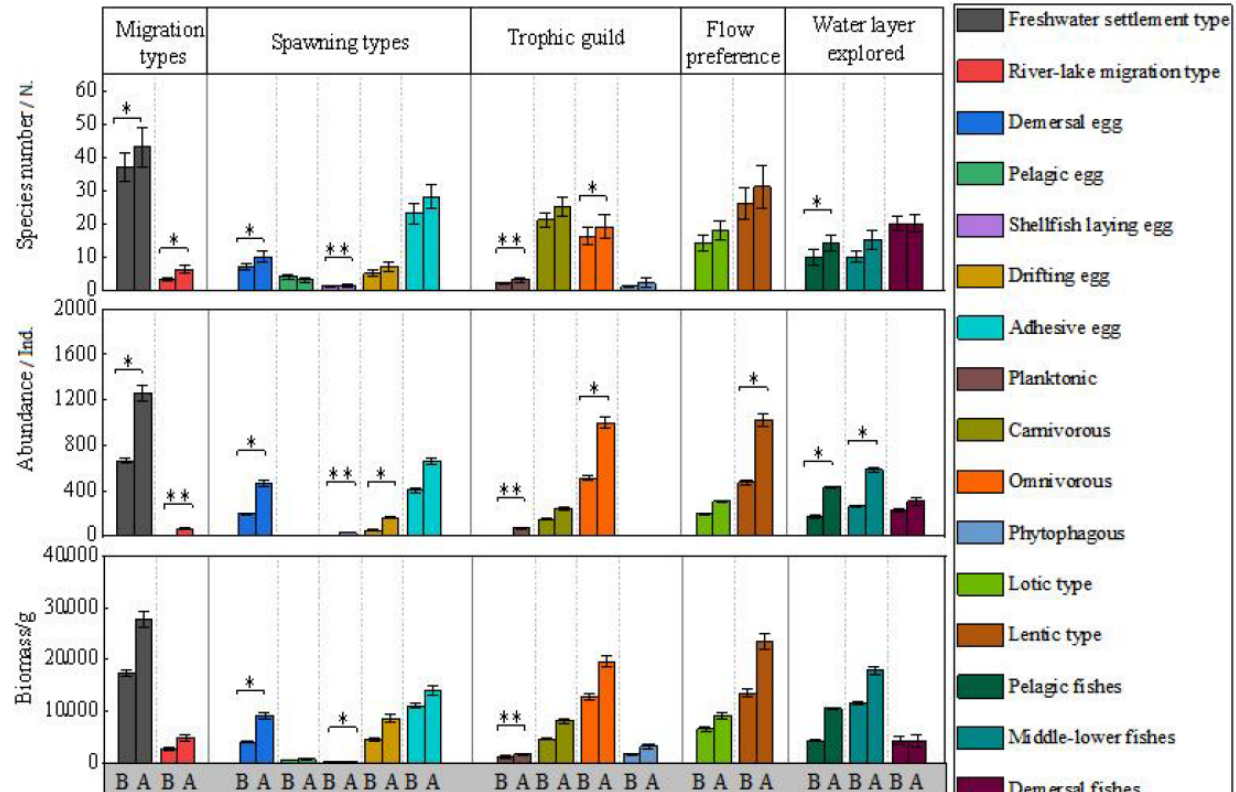
Figure 6. Differences in fish ecological behavior traits before and after the implementation of the project. The ecological habits of fish can be divided into 5 categories which can be specified into 16 subcategories. Error bars represent the standard deviation of each subcategory between all samples collected within a year before and after the project. One-way ANOVA was conducted between the data before and after the implementation of the project. “*” indicates significant difference ( p < 0.05) and “**” indicates extremely significant difference ( p < 0.01). “B” indicates before project implementation; “A” indicates after project implementation.